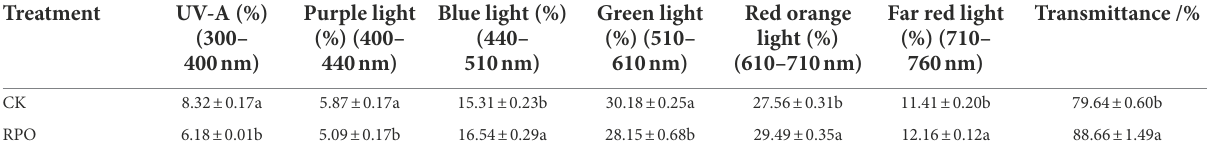
TABLE 1 Effect of RPO film on the spectral transmission ratio.